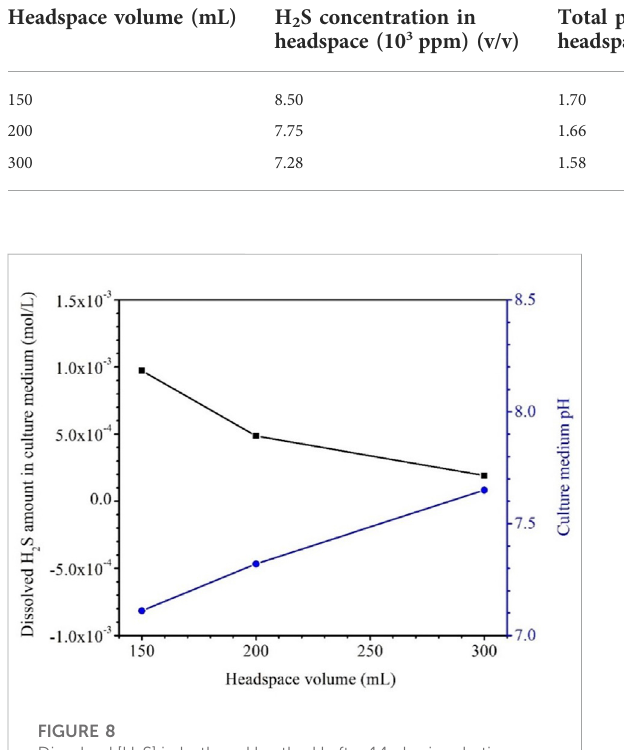
FIGURE 8 Dissolved [H 2 S] in both and broth pH after 14-day incubation in bottles with fi xed 150 ml broth and varied headspace volume.